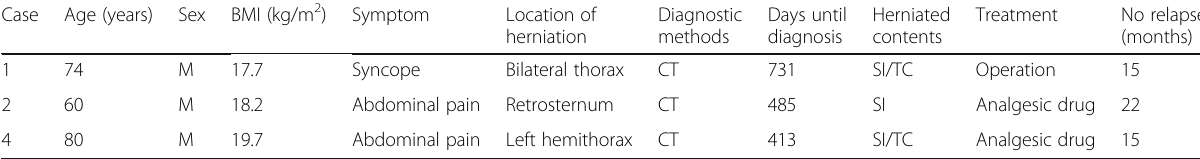
Table 1 Cases of retrosternal hernia after thoracolaparoscopic esophagectomy